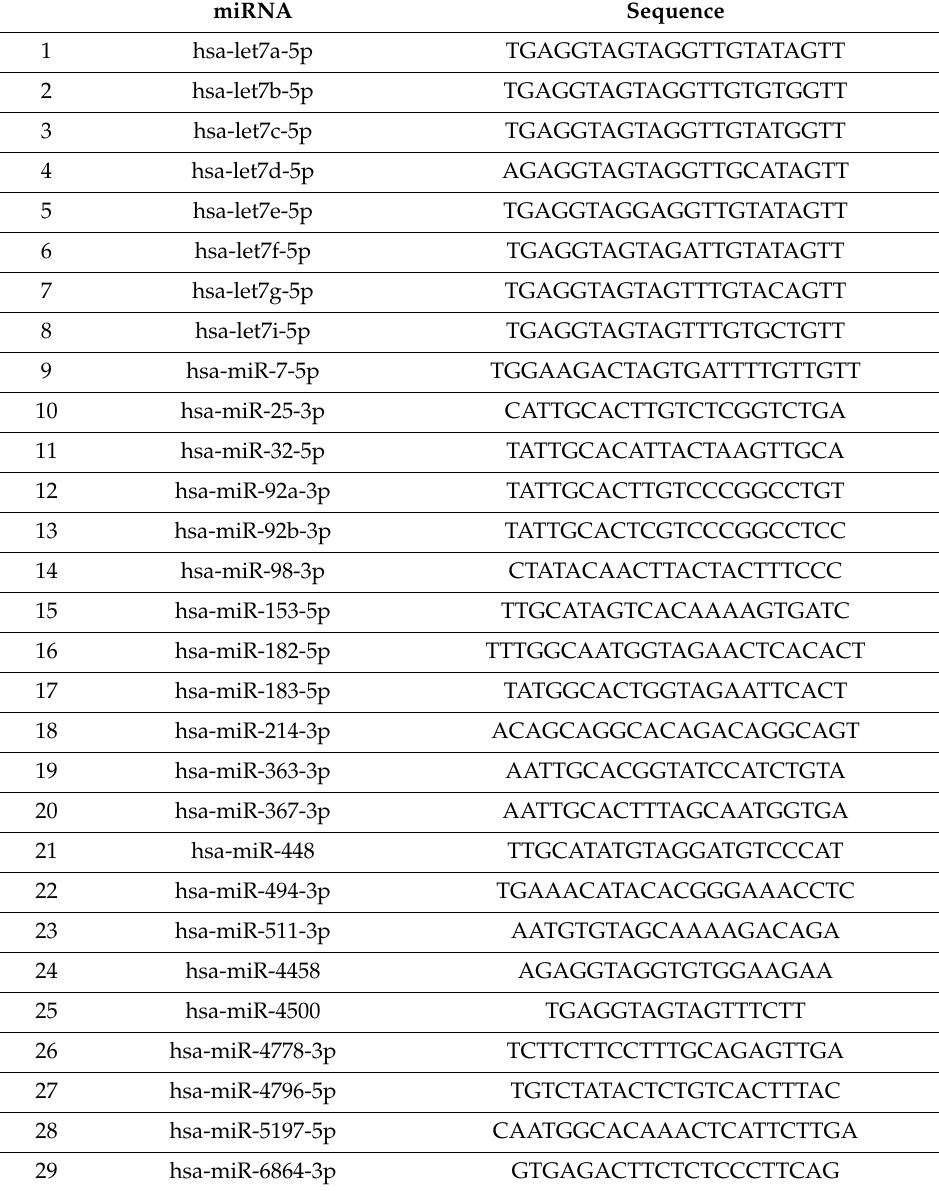
Table 2. List of miRNAs having strong binding potential against hTMPRSS2. TMPRSS2, transmembrane serine protease 2. miRNA